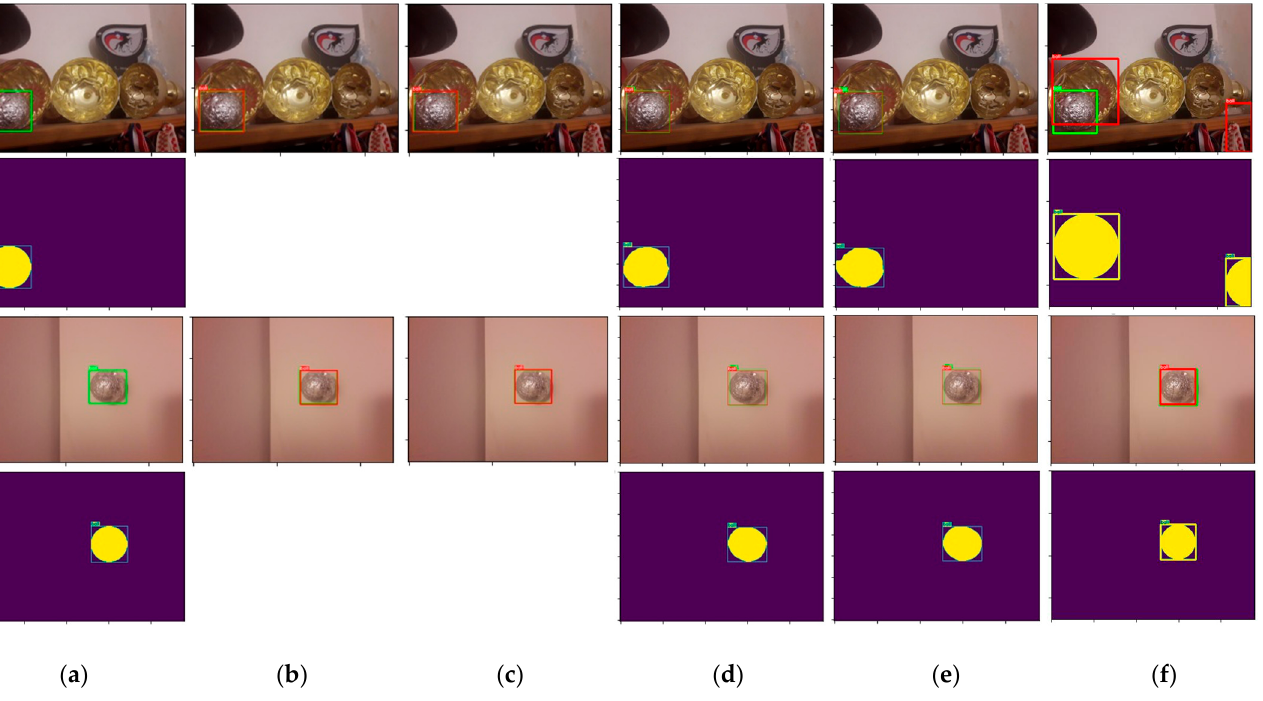
Figure 11. Comparison of predictions with bounding boxes. From left to right: ( a ) ground truth, ( b ) object detection MOBILENET_V3_LARGE_320 with threshold 95%, ( c ) object detection RESNET50 with threshold 95%, ( d ) semantic segmentation EFFICIENTNET_B0, ( e ) semantic segmentation MOBILENET_V2, ( f ) Hough 50-40-50. The first and third rows are images with bounding boxes, where green bounding boxes represent annotated ground truths and the red ones predicted objects. The second and fourth rows are masks with bounding boxes, where yellow pixels represent masks, and green or yellow lines represent bounding boxes. For object detection, masks were not created.